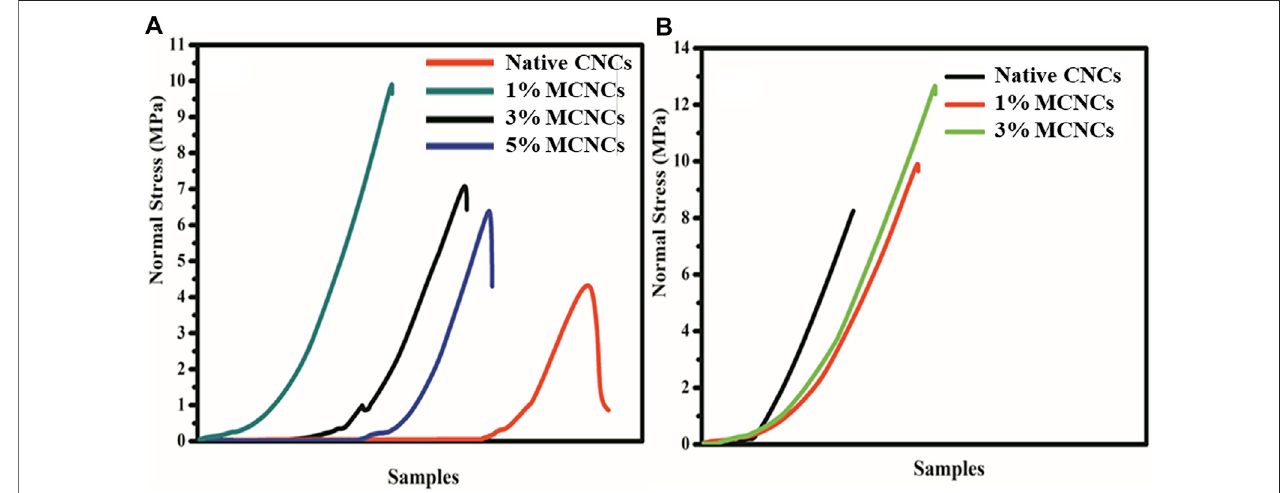
FIGURE 10 | Stress – strain curves of (A) standard and different concentrations (1%, 3%, and 5%) of native CNCs and (B) standard epoxy and epoxy-modi fi ed CNCs (i.e., MCNCs).